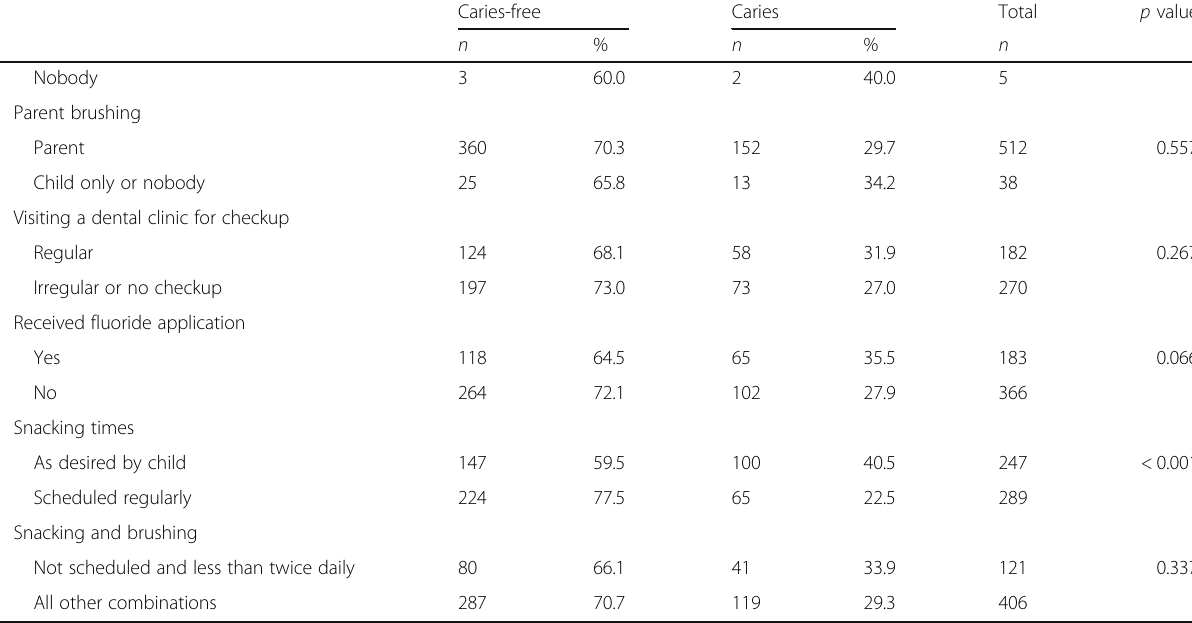
Table 4 Health habits associated with caries at follow-up ( n = 556) (Continued)